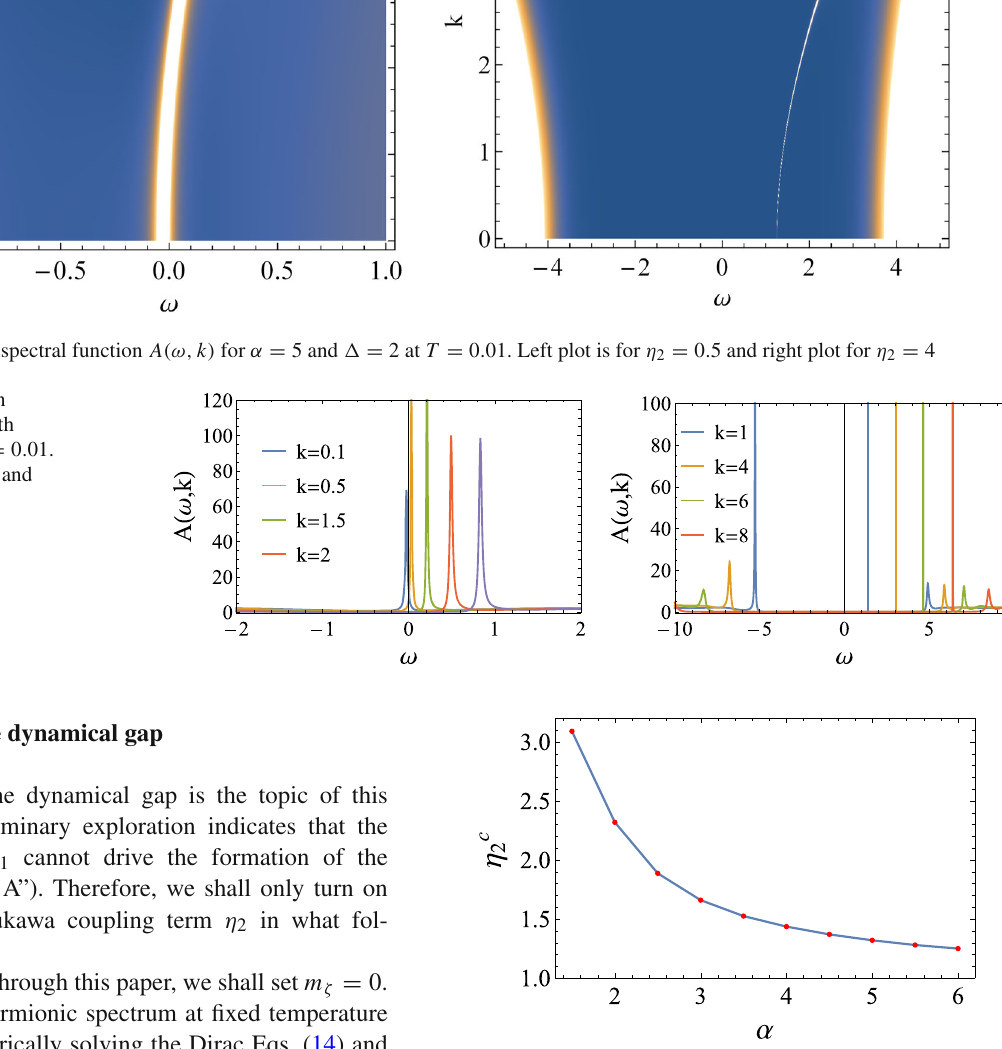
for fixed T = 0 . 2